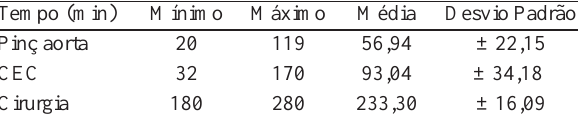
Fig. 1 - Correlação entre cistatina C e creatinina no pré-operatório; r: coeficiente de correlação; p: nível de significância